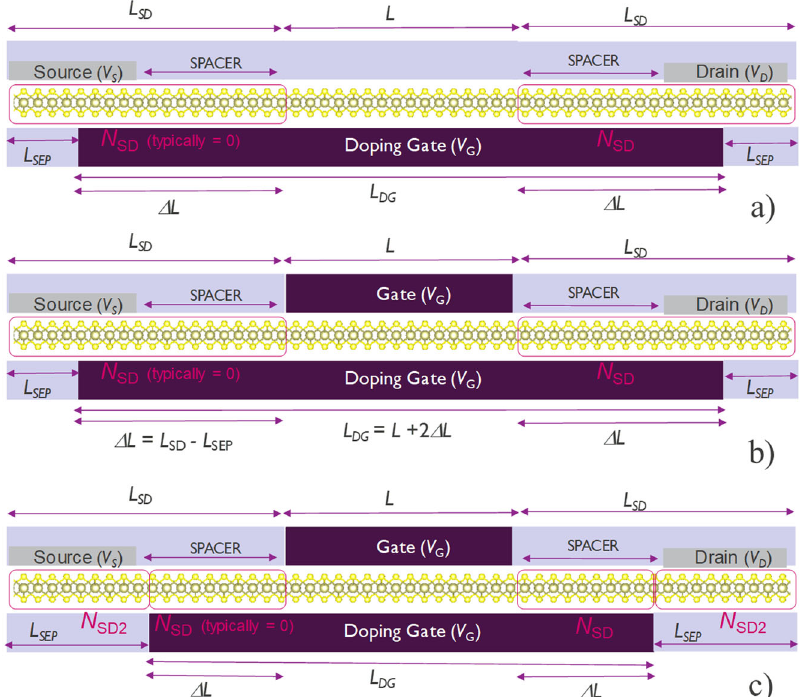
Fig. 12 Schematic view of 1 ML 2D D 2 -FETs. D 2 -FET with a a single gate, b a double gate, and c an alternative double-gate design with chemical doping in the source-and-drain-contact regions ( N SD2 ), larger L SEP , and shorter Δ L